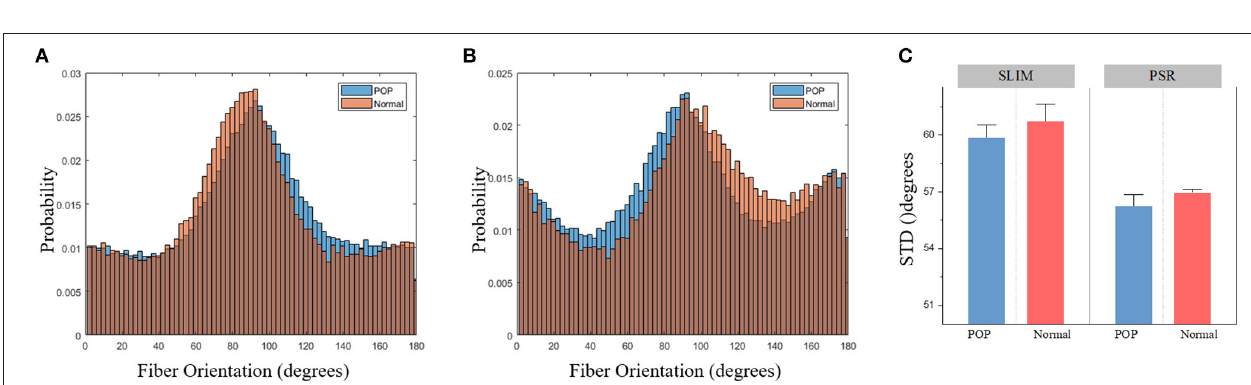
FIGURE 3 | Procedure of fiber extraction. CT-FRIE reads a 2D phase image (A) and generates a network of fibers, each rendered a different color and overlaid with the input image (B) , and 4 structural metrics are calculated for individual segmented result (C) .